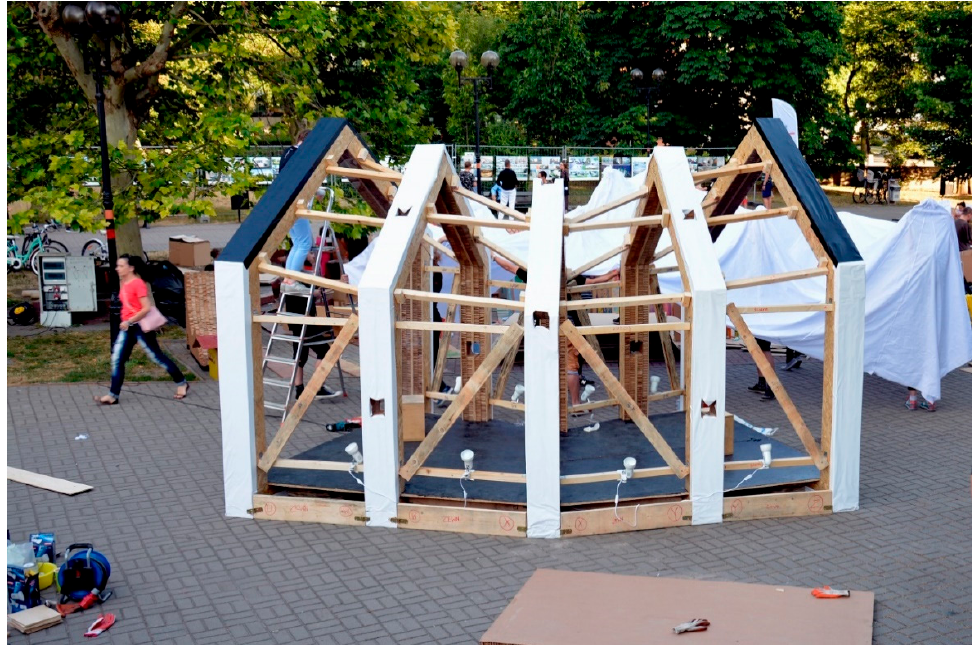
Figure 15. The substructure assembly process.